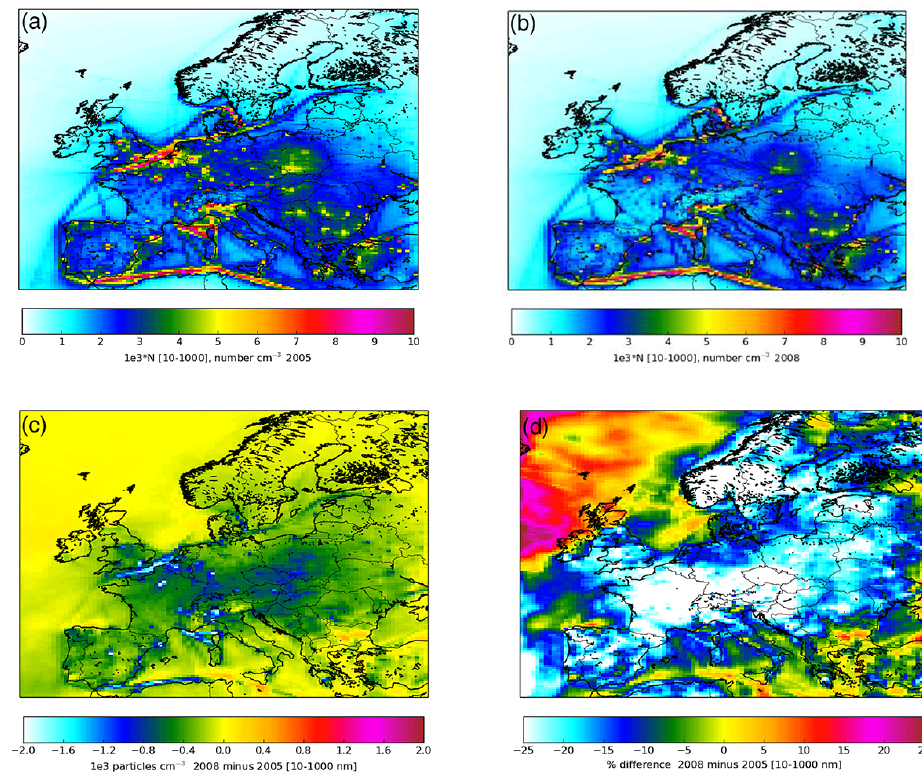
Figure 7. Predicted annual average particle number concentrations in Europe for 2005 (a) and for 2008 (b) , and the difference of the concentrations between these two years in absolute (c) and relative units (d) . The modelled particulate matter size range is from 10 to 1000nm. The unit in the legend is 10 3 particlescm − 3 in (a) , (b) , and (c) , and percentage differences are presented in (d) . Table 2. Data and coefficients required for the implementation of the PNC parameterization used in Oslo. Typical predicted timescales associated with deposition and coagulation are also